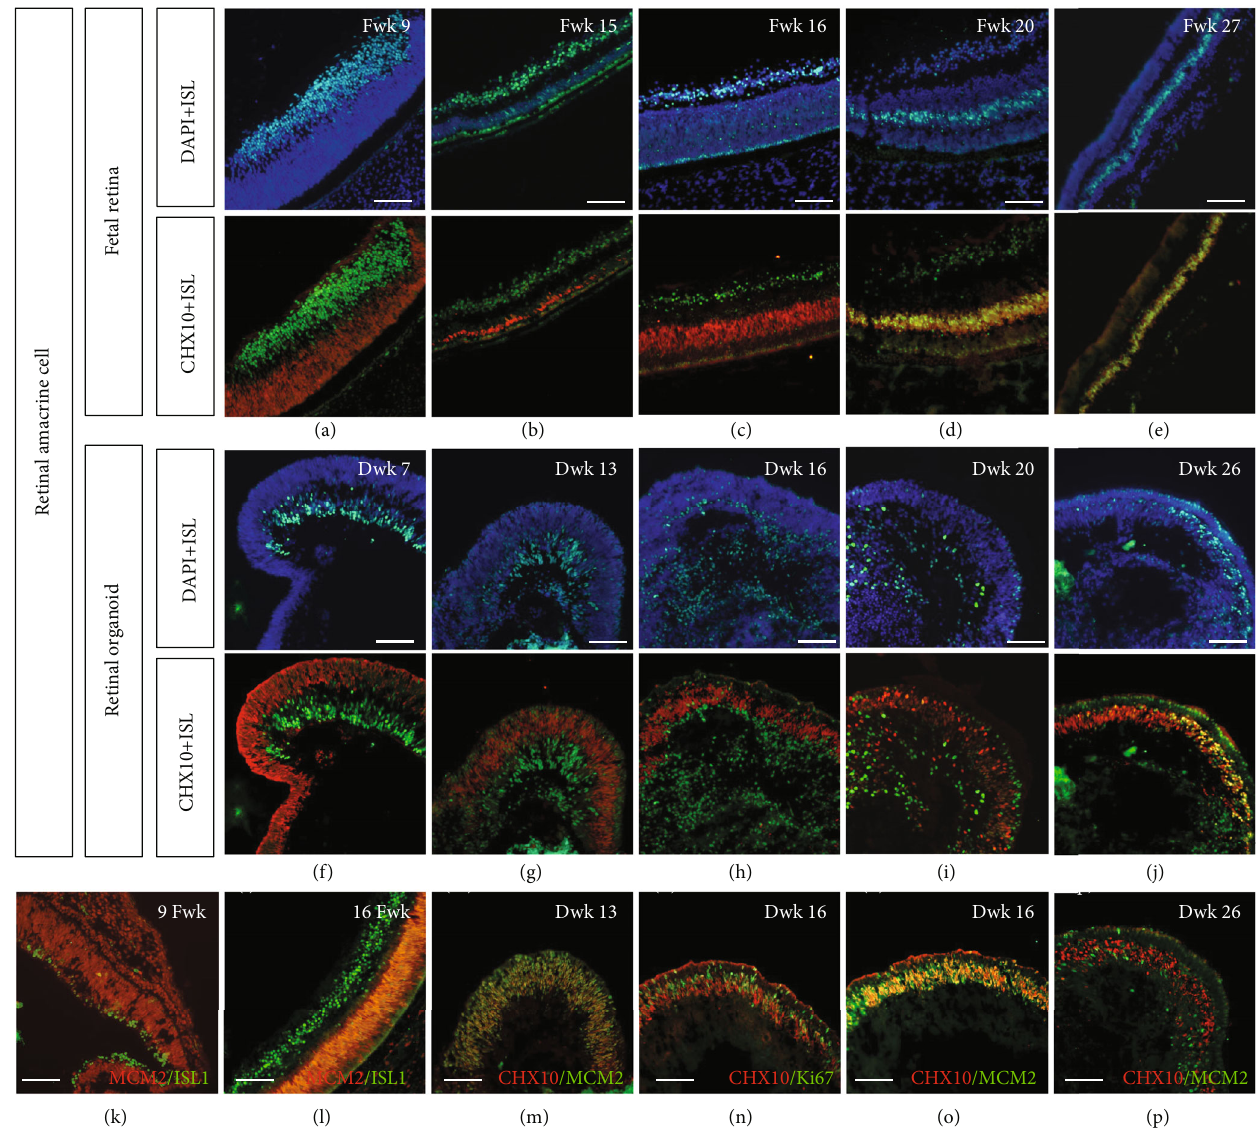
Figure 7: Coimmunolabeling of Islet1 and CHX10 in human fetal retinal and retinal organoid. (a – c) CHX10 did not colocalize with Islet1 in the early stage, indicating CHX10 is a retinal progenitor marker during this period. (d, e) Layer of double-positive bipolar cells settled in the INL in the fetal retina. (f – i) CHX10-labeled retinal progenitors in the neuroblast layer in retinal organoids. (j) Some CHX10-positive cells colabeled with Islet1. (j, k) Another neural progenitor marker, MCM2, revealed undi ff erentiated cells in the fetal retina. (m – o) MCM2 and cell cycle marker, Ki67, con fi rmed that CHX10 was expressed in progenitors in this period rather than in bipolar cells. (p) To Dwk 26, CHX10-positive bipolar cells were MCM2 negative ( scale bar = 100 μ m